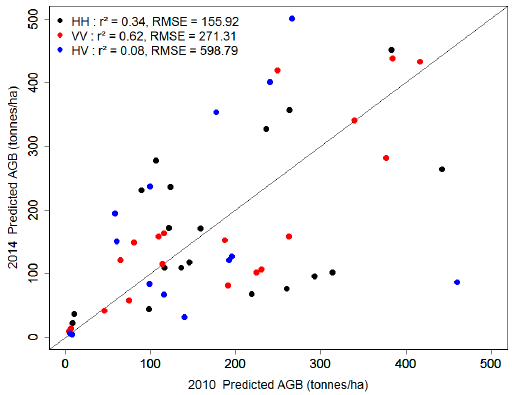
Figure 10. Cross-comparison of S-band predicted forest AGB between 2010 and 2014 (Training plots).